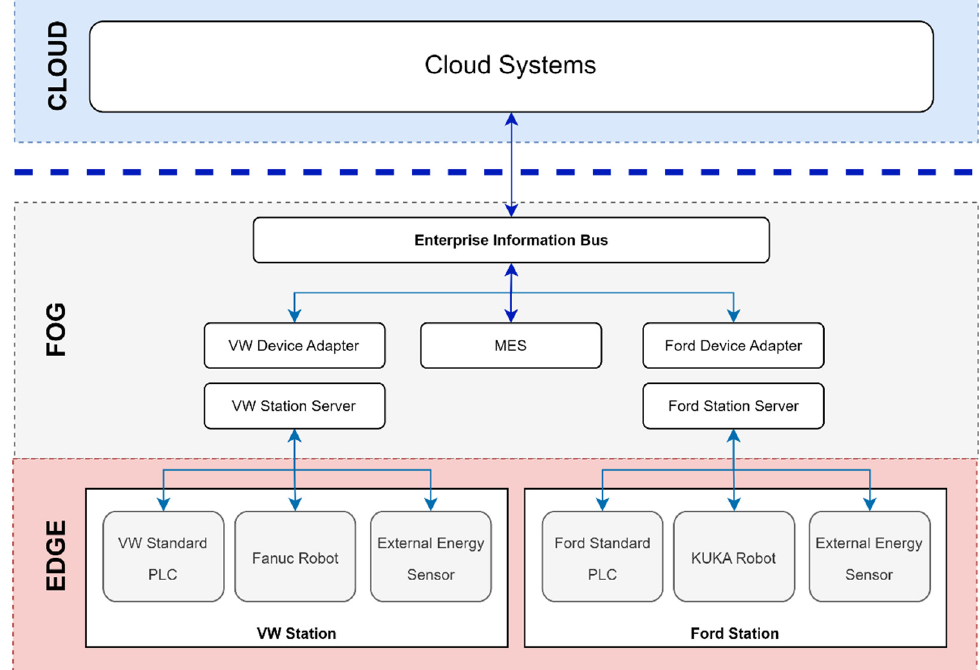
Figure 4. Orchestrator provided with the Introsys cells.